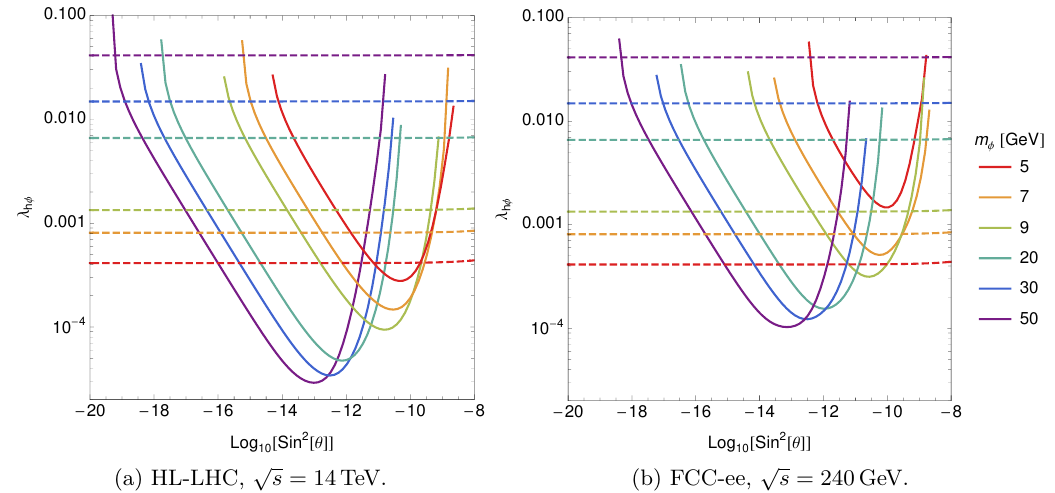
Figure 5 . Bounds on λ hφ and sin 2 θ for various singlet masses arising from searches for delayed jets in Higgs decays. The dashed lines show the upper naturalness limit λ max